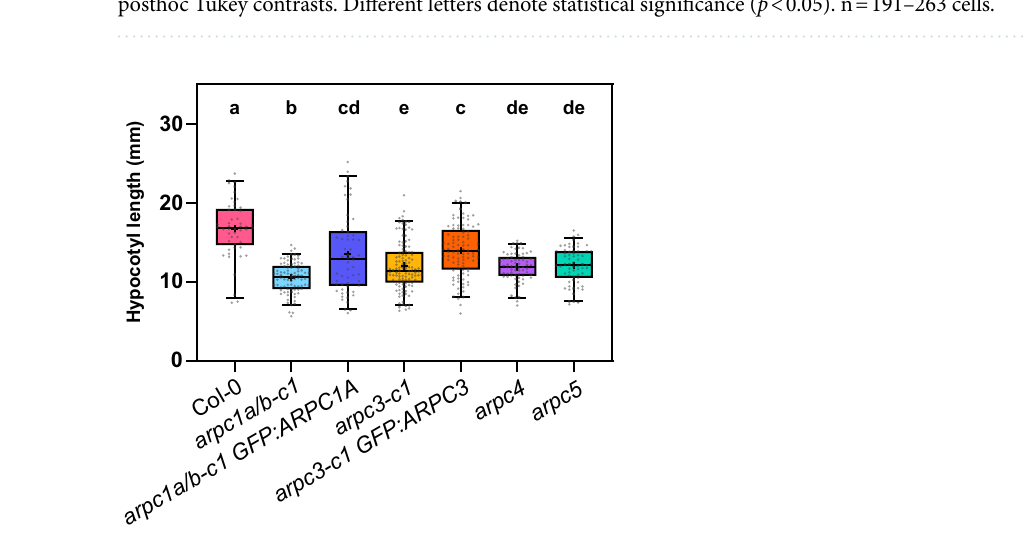
Figure 4. Dark-grown hypocotyl length evaluation. Hypocotyl length analysis of etiolated seedlings for the lines generated in this study ( arpc1a/b-c1 , arpc3-c1 ), their respective fluorescent-labeled rescue lines ( arpc1a/ b-c1 35S::GFP:ARPC1A , arpc3-c1 35S:GFP:ARPC3 ) and control lines (Col-0, arpc4 , arpc5 ). Hypocotyl analysis of dark-grown 6-day-old plants shows reduced hypocotyl length for all lines lacking single ARP2/3 complex subunits, and a partial recovery of the corresponding rescue lines. Statistical analysis was performed fitting a linear mixed model on the original data followed by a posthoc Tukey HSD multiple comparison test. n = 50–117 plants. Different letters denote statistical significance ( p <